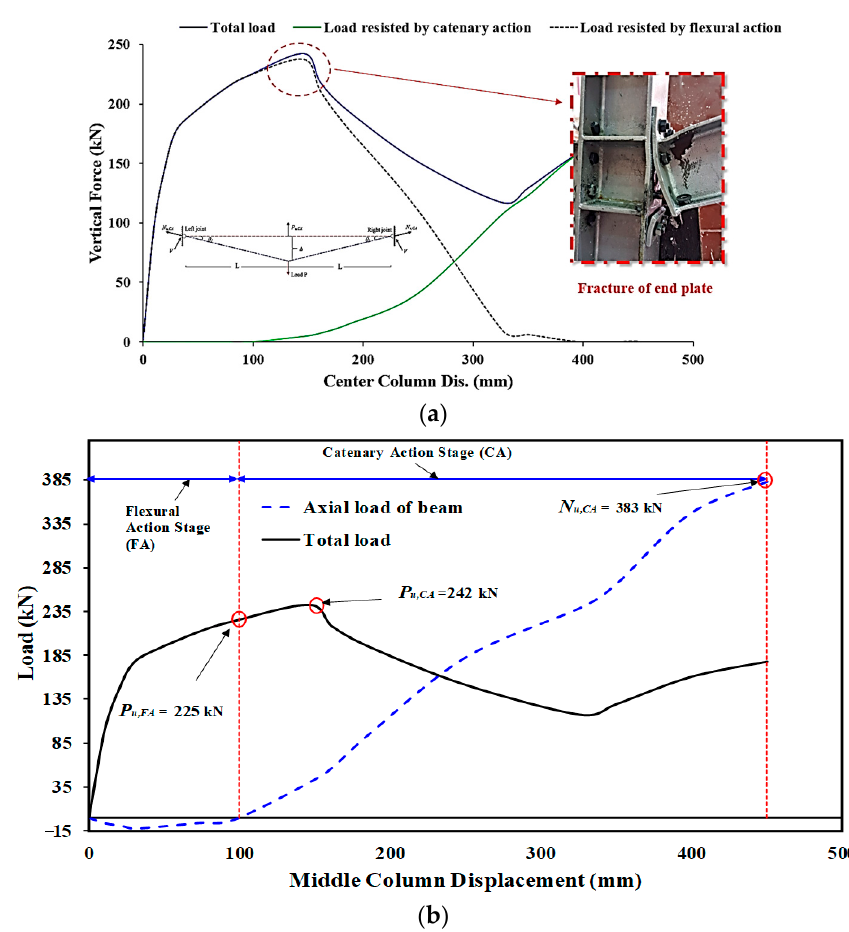
Figure 6. Characteristics of force and center steel-column displacement for J-M-C: ( a ) Curves of force and center column displacement, and ( b ) Curves of CA & flexural phases [6].